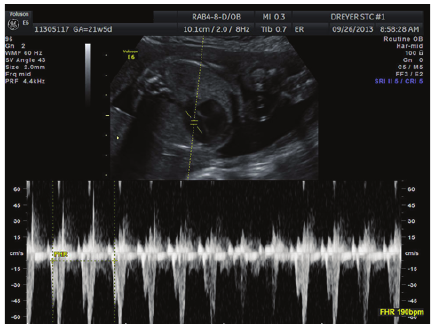
Figure 1: Fetal tachycardia.